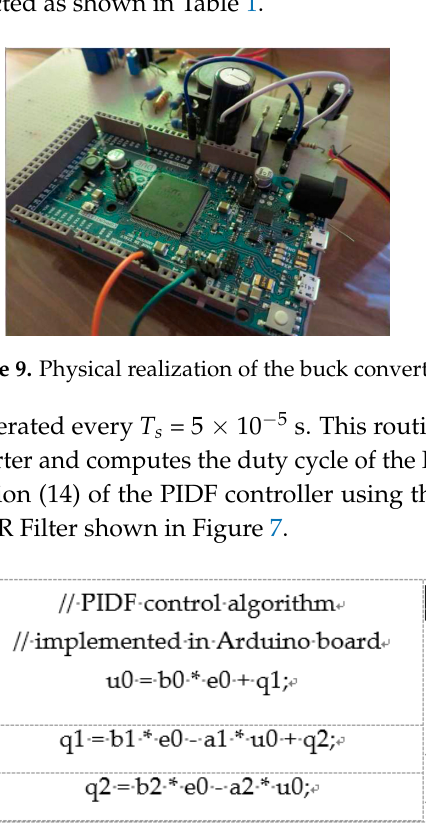
Figure 10. The Biquad Cascade IIR Filter algorithm.